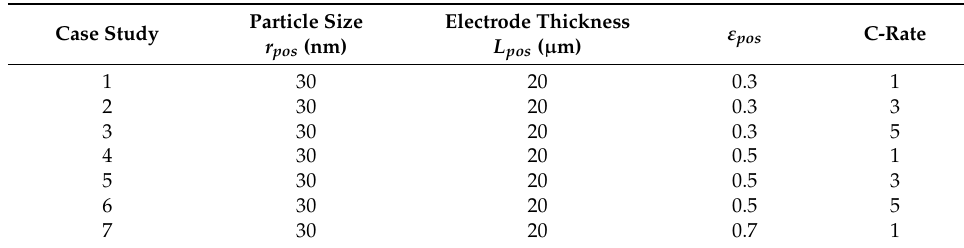
Table A2. The simulated case studies for the full factorial